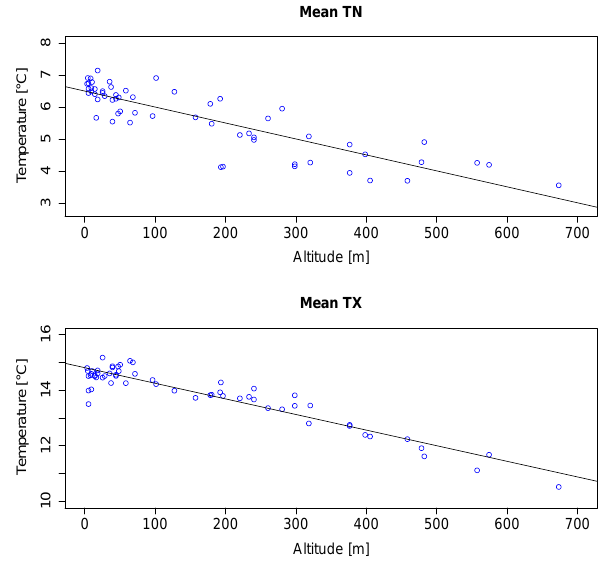
Figure 5. Correlation between station elevation and daily mean temperature (for the reference stations). The correlation coefficients are of − 0.85 and − 0.93 for TN and TX ,